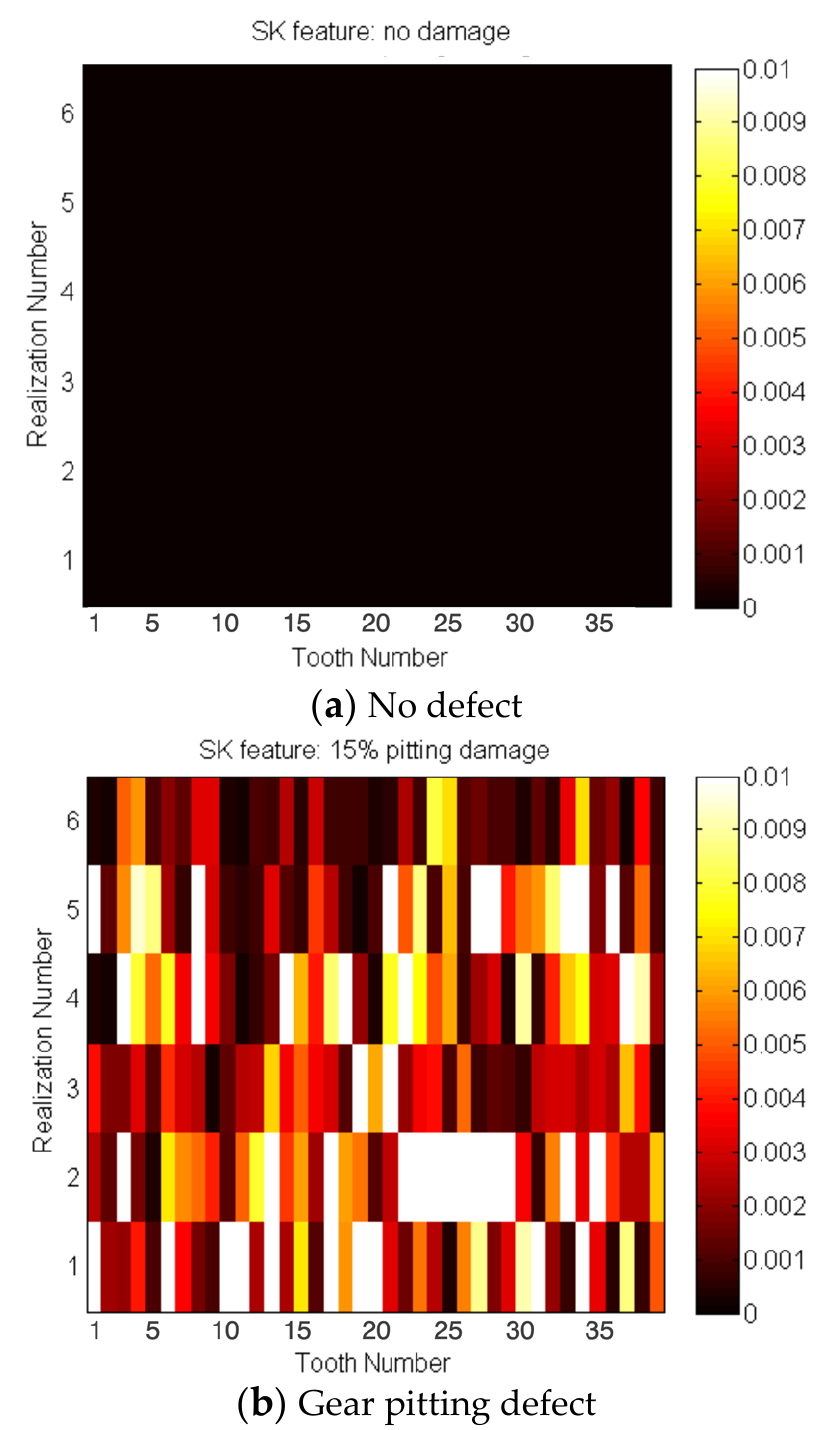
Figure 12. The diagnostic features—squared envelope of the filtered SK-residuals from gear signal.